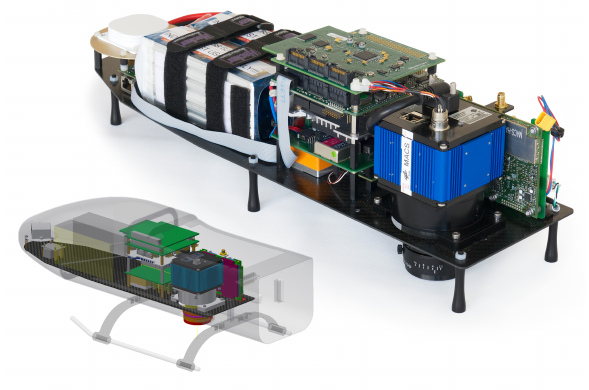
Figure 1. DLR MACS UAV camera system: Upper right: assembled prototype. Lower left: CAD model with UAV